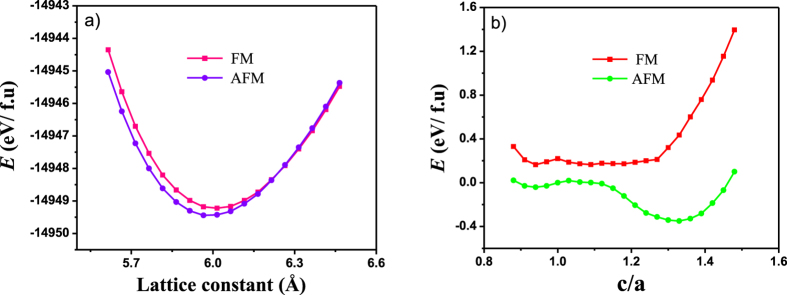
(a) Equation of states of Ni2Mn1.5Sn0.5 cubic phases for both parallel and antiparallel magnetic interactions. (b) The total energies E of Ni2Mn1.5Sn0.5 with a variation of the tetragonal ratio c/a.